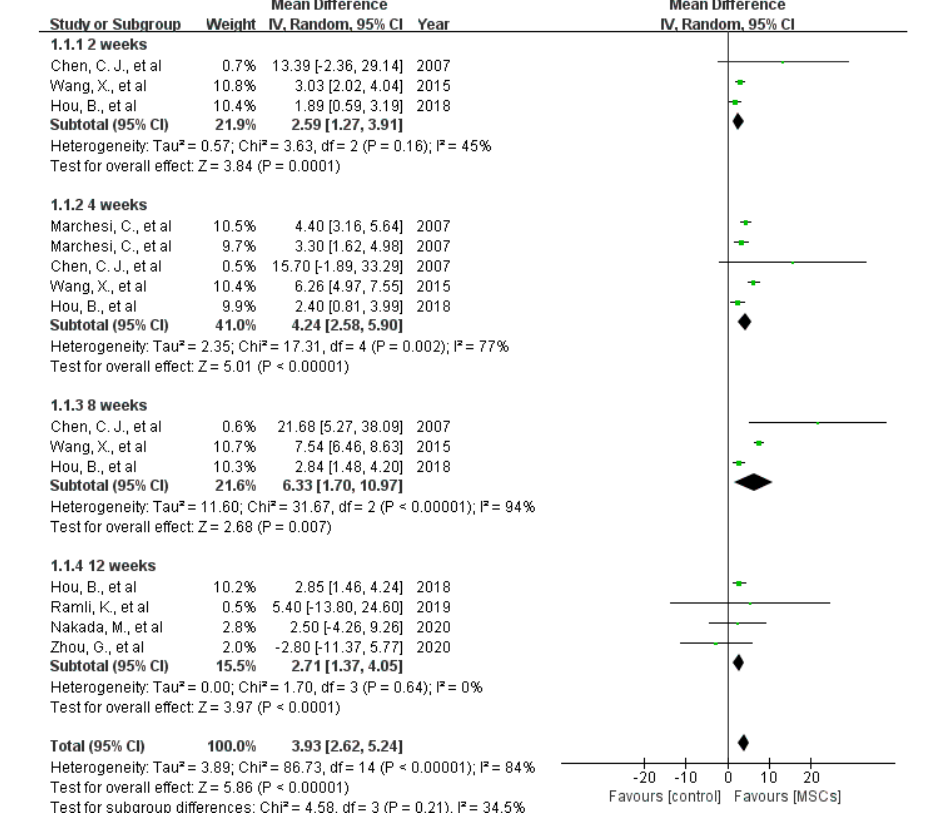
Figure 4. The forest plot shows the effect of MSCs on the sciatic functional index 2 weeks, 4 weeks, and 12 weeks after surgery [5,11–36]. Plots on the right ‐ hand side indicate favoring MSCs or MSCs ‐ loaded scaffolds, while plots on the left side indicate favoring placebo ‐ control treatment or blank scaffolds.